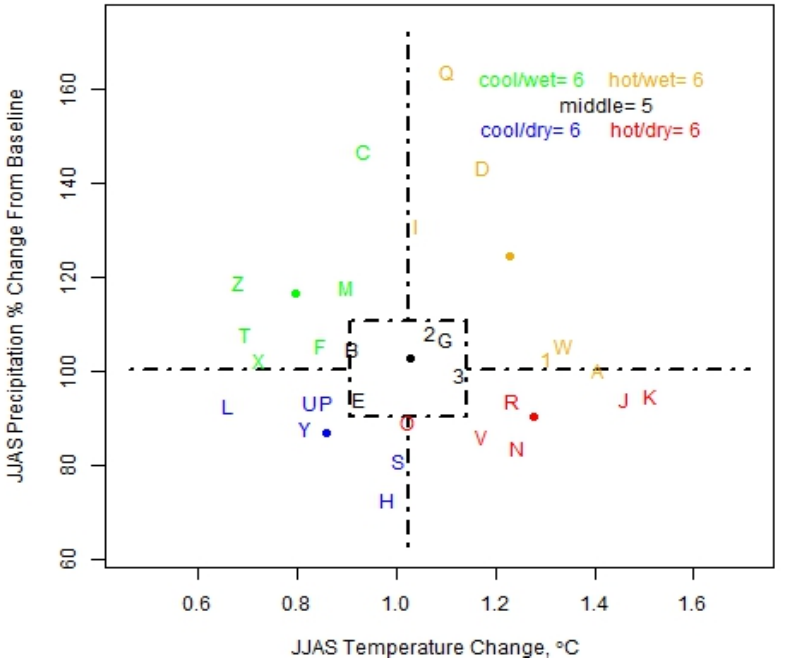
Figure 5. Percentage rainfall change vs. temperature change for Sebwe and Mubuku sub catchment under RCP8.5 climate scenario.